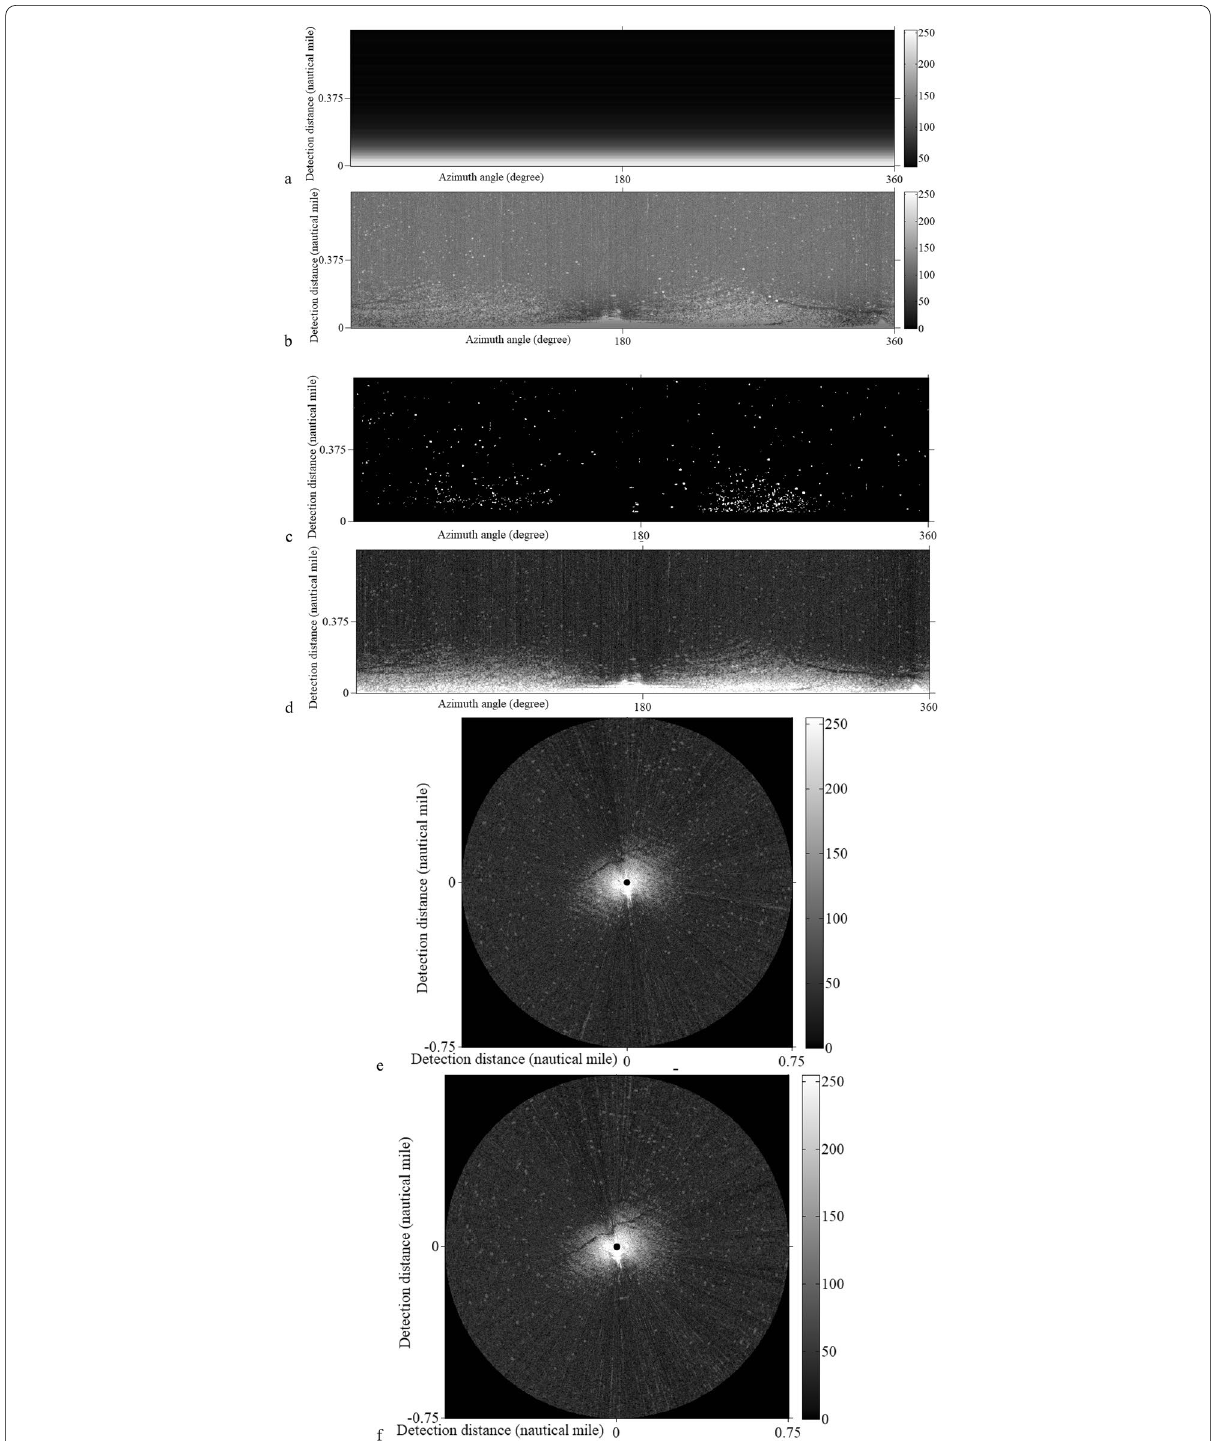
Fig. 6 Data preprocessing results. a GICM model of Fig. 5d; b subtraction of Fig. 5d and a . c Highlighted targets segmentation by using gray threshold (160) and area threshold (100); d linear interpolation suppression; e , f are the preprocessed results of images collected at 23:18:56 and 23:19:07,